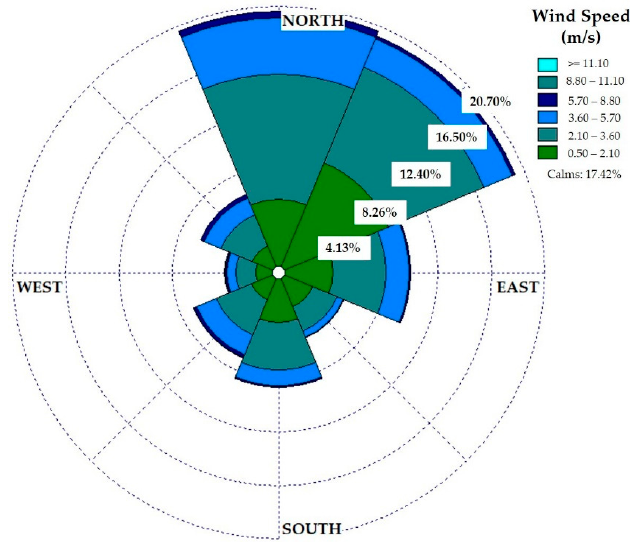
Figure 2. Wind strength and direction in the region, from January 2016 to September 2020.